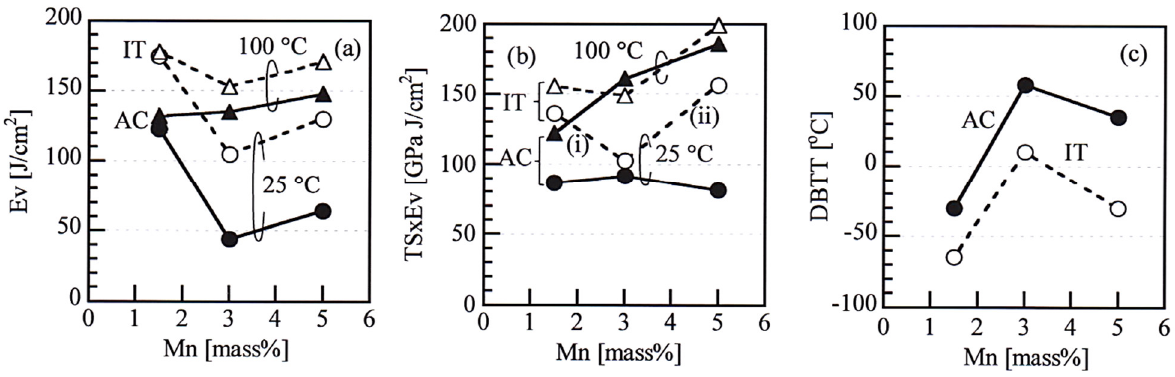
Figure 8. Variations in ( a ) Charpy V-notch impact value ( E v ) and ( b ) the product of tensile strength and E v (TS × E v ) at T t = 25 °C (circle marks) and 100 °C (triangle marks) and ( c ) 50% shear fracture ductile-brittle transition temperature (DBTT) as a function of Mn content in the steels subjected to the AC ( ●▲ ) and IT ( ○△ ) processes. In ( b ), (i) and (ii) represent the contributions of mechanical stability and volume fraction of reverted austenite, respectively.